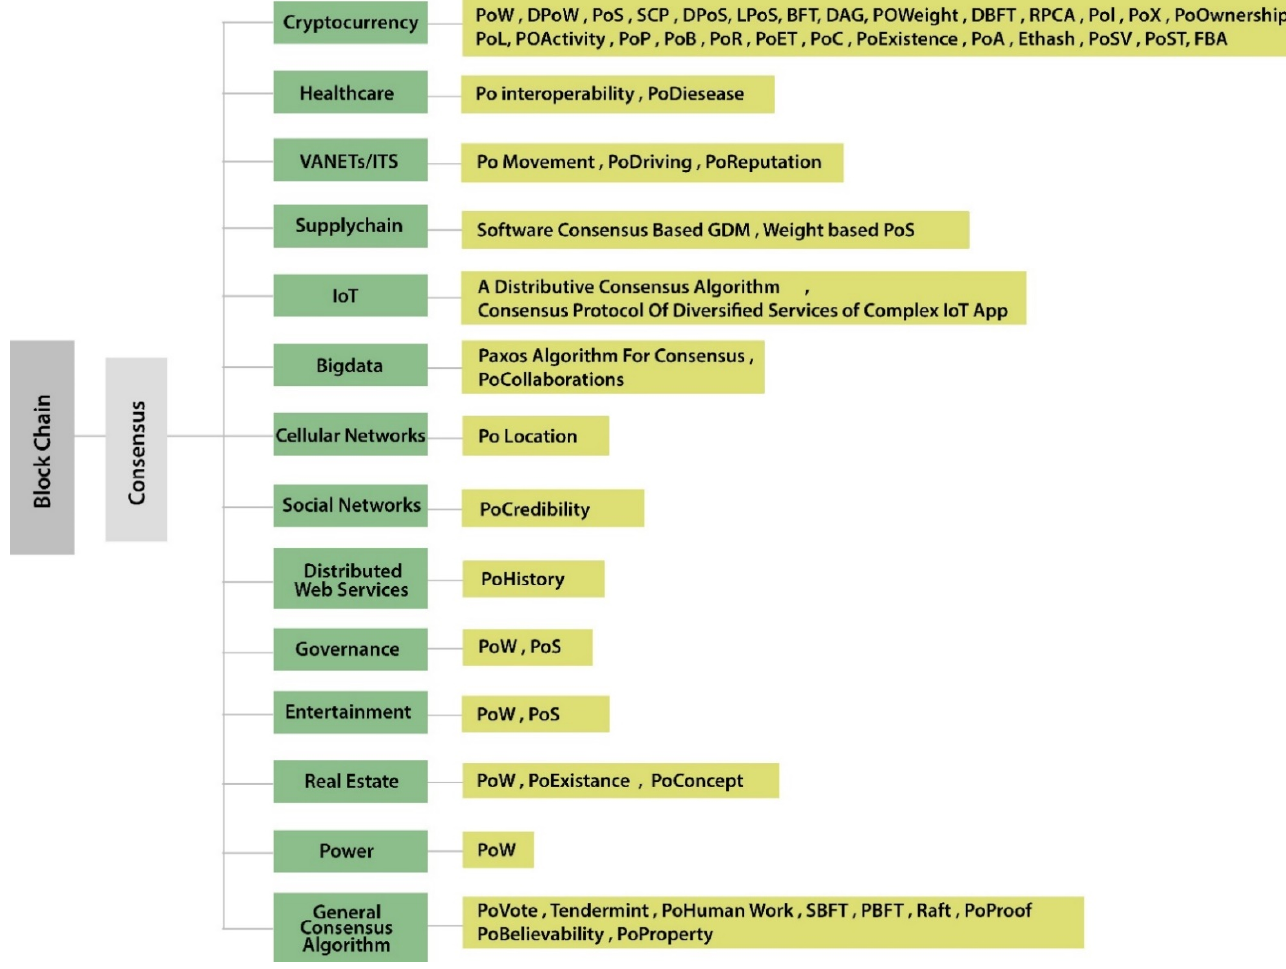
Figure 5. Categorization of the consensus algorithms.